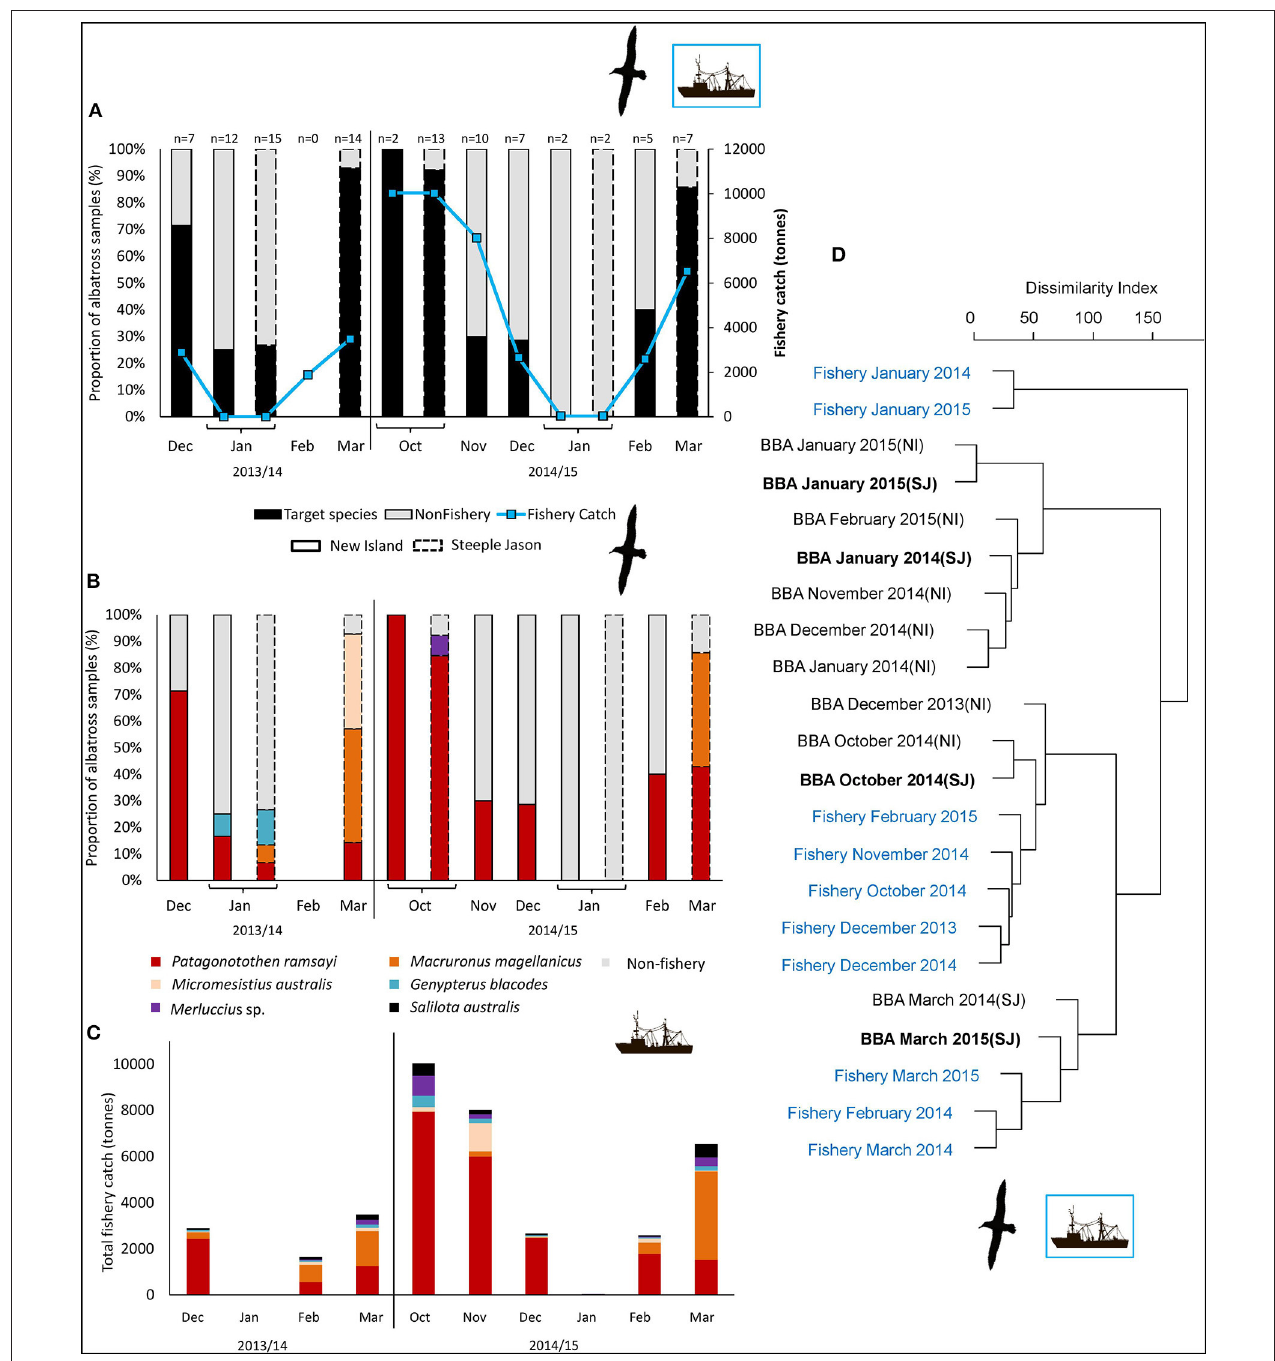
FIGURE 6 | Comparison between back-browed albatross fish prey and fishery catch amounts at the Falkland Islands by month from December 2013-March 2014 (excluding February) and October 2014 to March 2015. Solid borders represent New Island; dashed borders represent Steeple Jason. (A) Scats with or without fishery target species (black and gray bars, respectively), compared to the total catch in the fishery (blue line). (B) The proportion of scat samples containing each of the target species. (C) Total catches in the fishery by species. (D) The hierarchical clustering of albatross diet and fishery catch data by month, based on the proportion of sequences (RRA, black text) and proportion of catch (blue text). Clusters were based on dissimilarity indices calculated with the Manhattan method, and hierarchical clustering was constructed using the average agglomeration method (note low sample sizes during January 2014 and 2015). As food DNA may persist